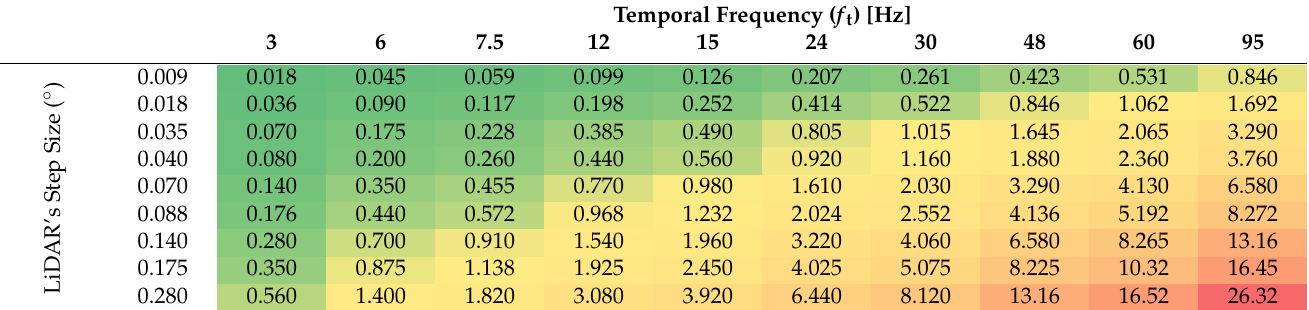
Table 9. Angular Frequency ( f a ). Based on the Temporal Frequency and Step Size.